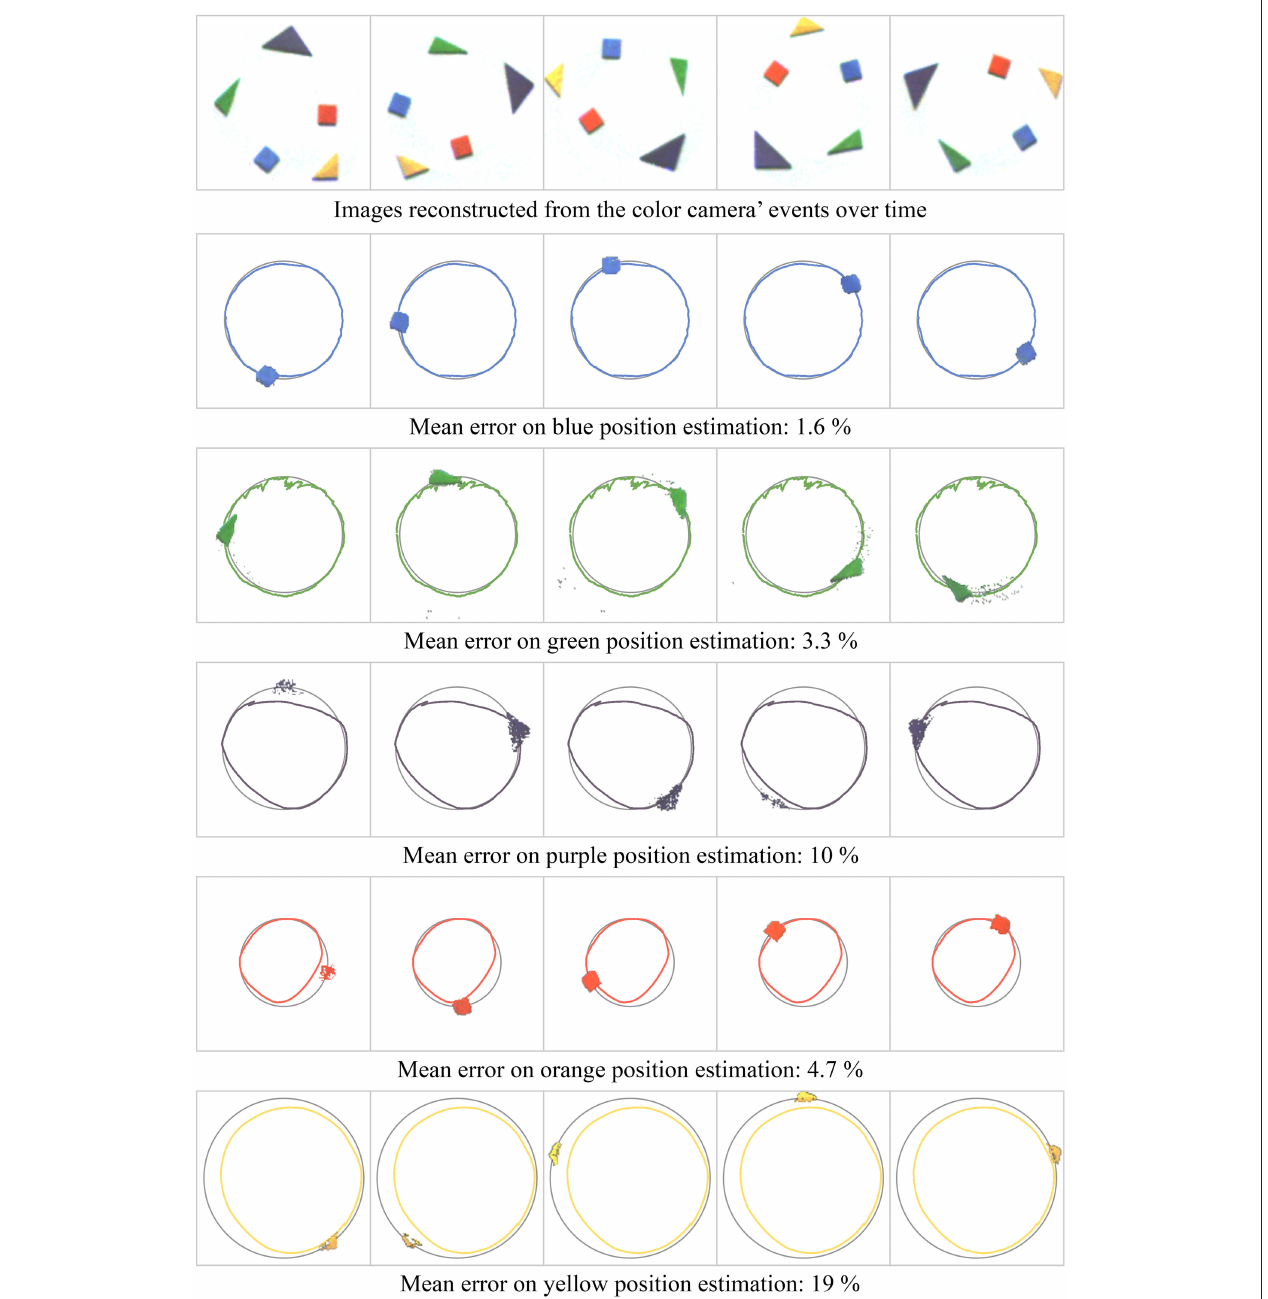
FIGURE 7 | Tracking of five wooden pieces in rotation motion. Figures show the pieces motions estimated with our method (colored trajectories) and the ground truth (gray trajectories) for a whole rotation. The mean error for each object is the average distance between the estimated object’s mean position and the ground truth as a ratio of the yellow object’s trajectory’s radius. The observed errors derive from the compromise between noise robustness and accuracy imposed by the moving mean algorithm.